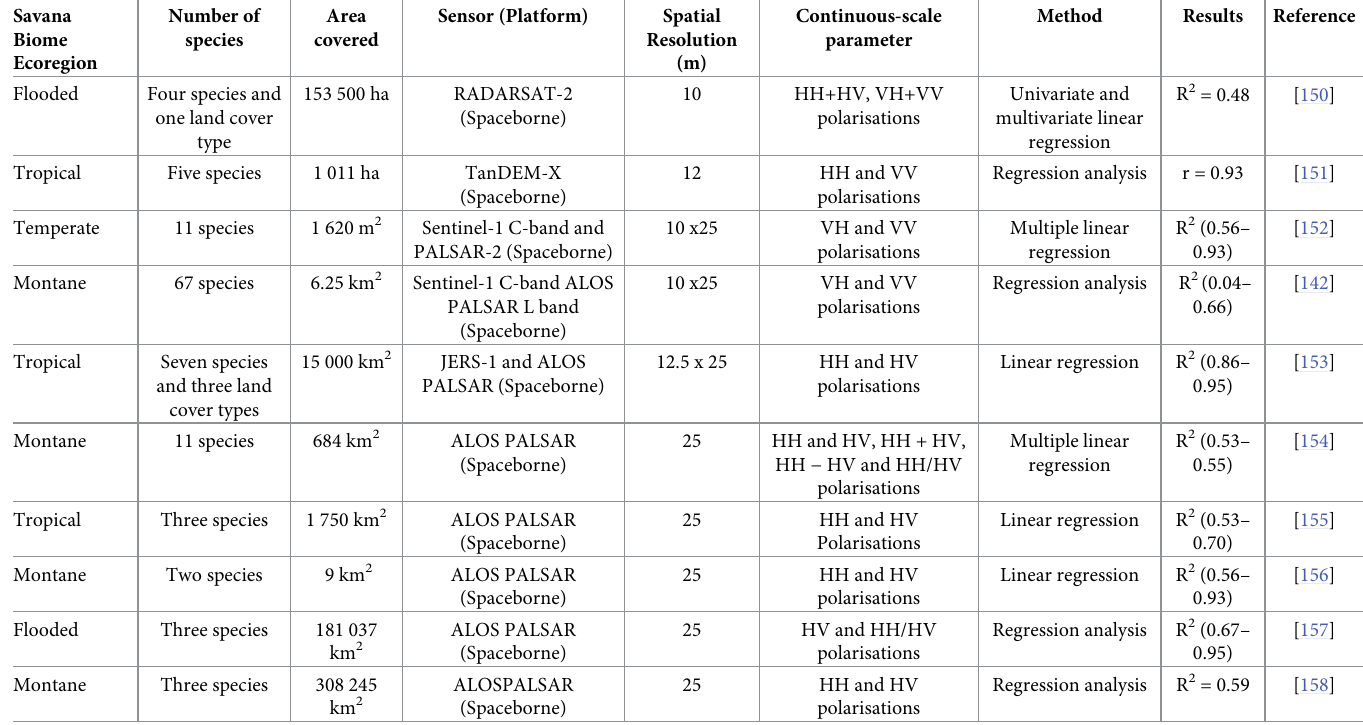
Table 5. Examples of studies that estimated savanna woody plant species diversity using RADAR remote sensing and